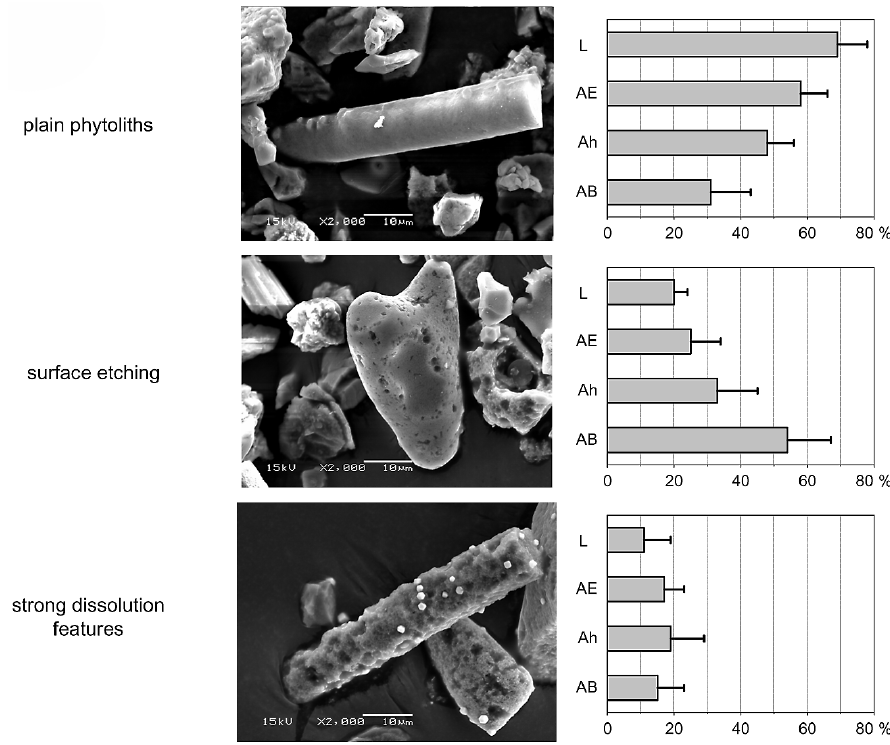
Fig. 7. Categories and depth functions of phytolith dissolution (based on counting in SEM micrographs): fresh, plain phytoliths (up- per), phytoliths showing clear signs of surface etching (middle), and phytoliths showing strong dissolution features (lower); horizontal bars=mean ± SD ( n =10 micrographs), total number of phytoliths counted: L=462, AE=459, Ah=422,